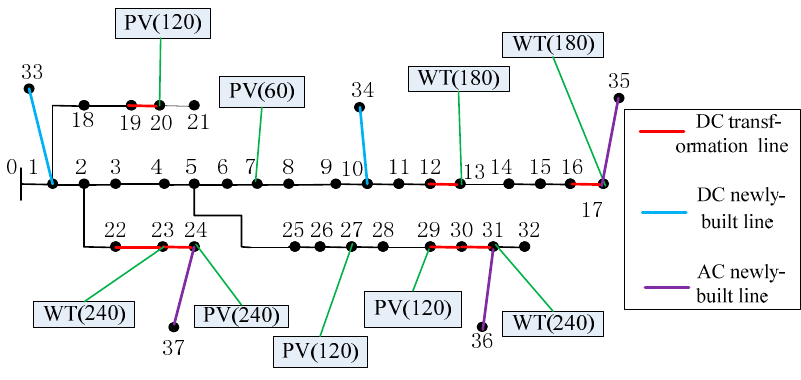
Figure 12. The structure of the AC/ DC hybrid DN after the planning.